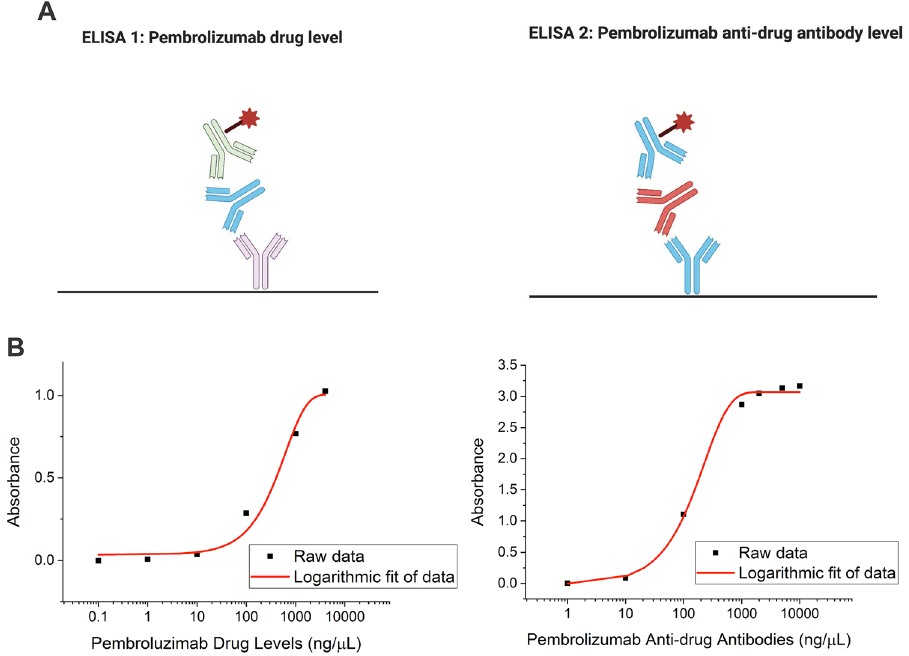
Figure 1. Pembrolizumab drug level and anti-drug anti-bodies: assay overview and standard curves . ( A ) Schematic of (left) pembrolizumab drug level assay. Sandwich enzyme-linked immune-sorbent assay (ELISA) with capture antibody (purple) that binds patient serum-derived pembrolizumab (blue). Detection antibody (green) is conjugated to horseradish peroxidase (HRP; red star) facilitating colormetric quantitation. Pembrolizumab anti-drug anti-body (ADA) assay (right) was achieved by sandwich ELISA using commercial pembrolizumab capture antibody (blue) to detect patient serum-derived ADA (red). Detection antibody was commercial pembrolizumab (blue) conjugated to HRP (red star). ( B ) Performance of commercial standard curved for pembrolizumab drug level (left) and ADA (right) are shown.